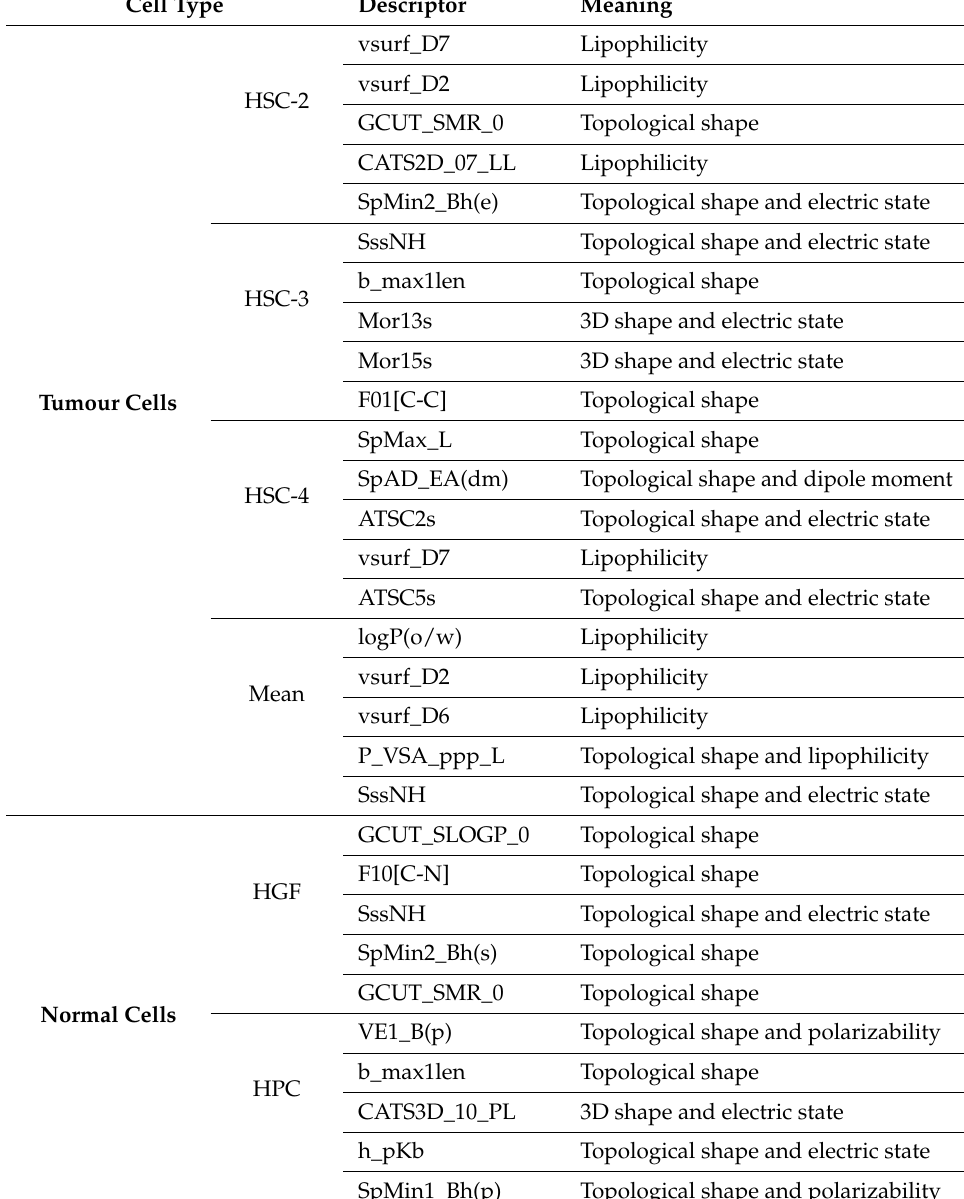
Table 4. Top five contributing descriptors for random forest prediction